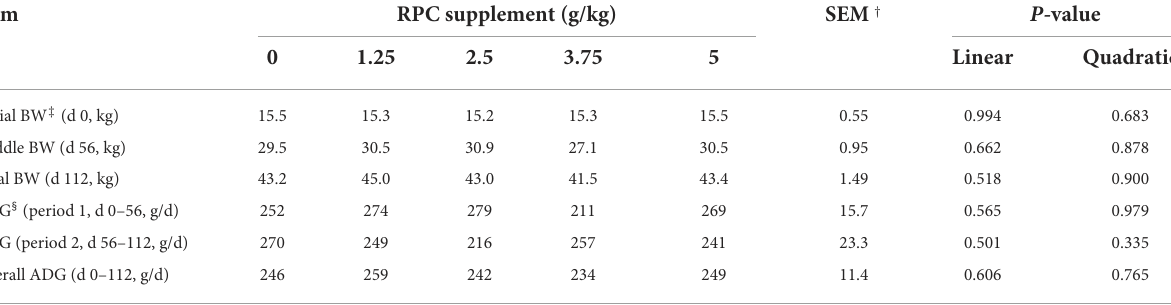
TABLE 2 Growth performance of fattening lambs fed experimental diets supplemented with nil (CON) or rumen-protected choline (RPC) ( n = 12 per treatment).